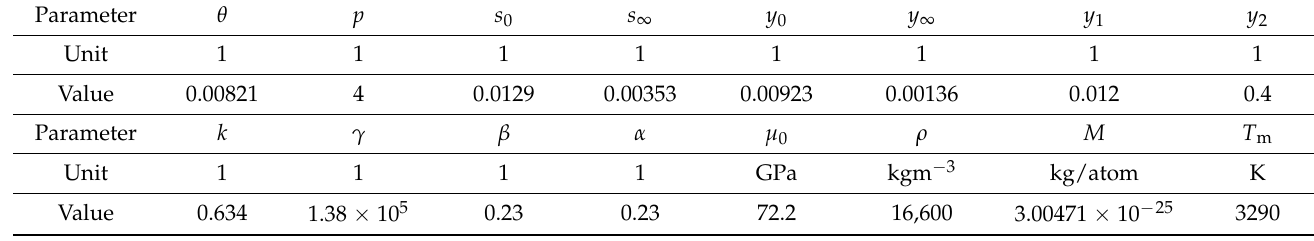
. . ε / ε ∗ ) curves at different temperatures are superposed; the higher ranges where σ vs. log ( the temperature, the wider the superposition range in log ( Table 12. Parameters of the PTW model for tantalum ( T m = 3290 K) [24]. Table 12. Parameters of the PTW model for tantalum ( T m = 3290 K) [24].